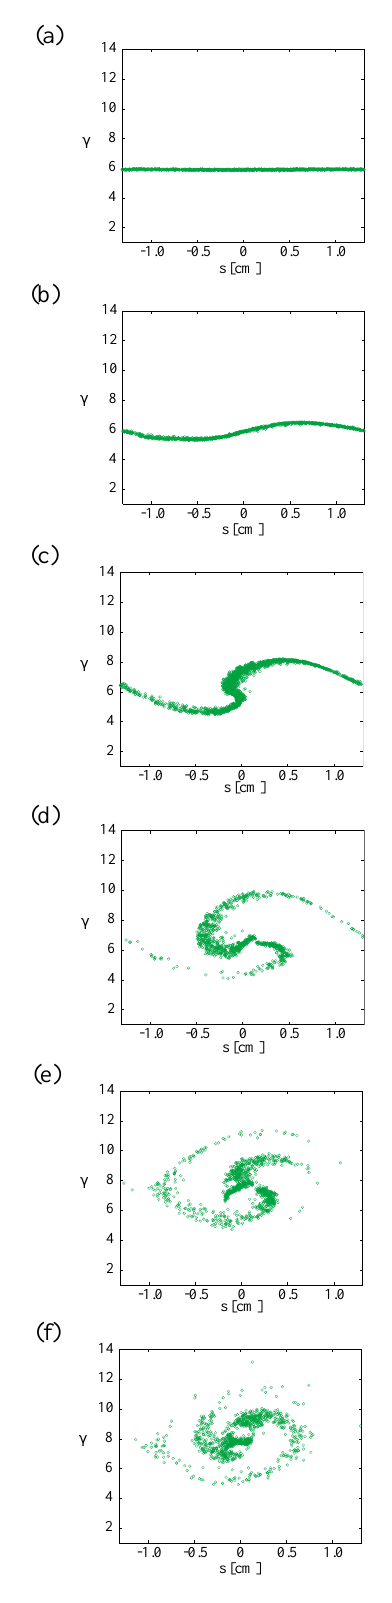
FIG. 7. (Color) Longitudinal phase-space distribution of par- ticles in a single rf bucket after passing through cavities #1 (a), #5 (b), #10 (c), #15 (d), #25 (e), and #35 (f).